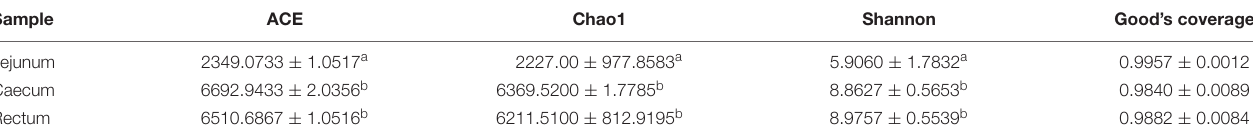
TABLE 1 | Collation results of alpha diversity